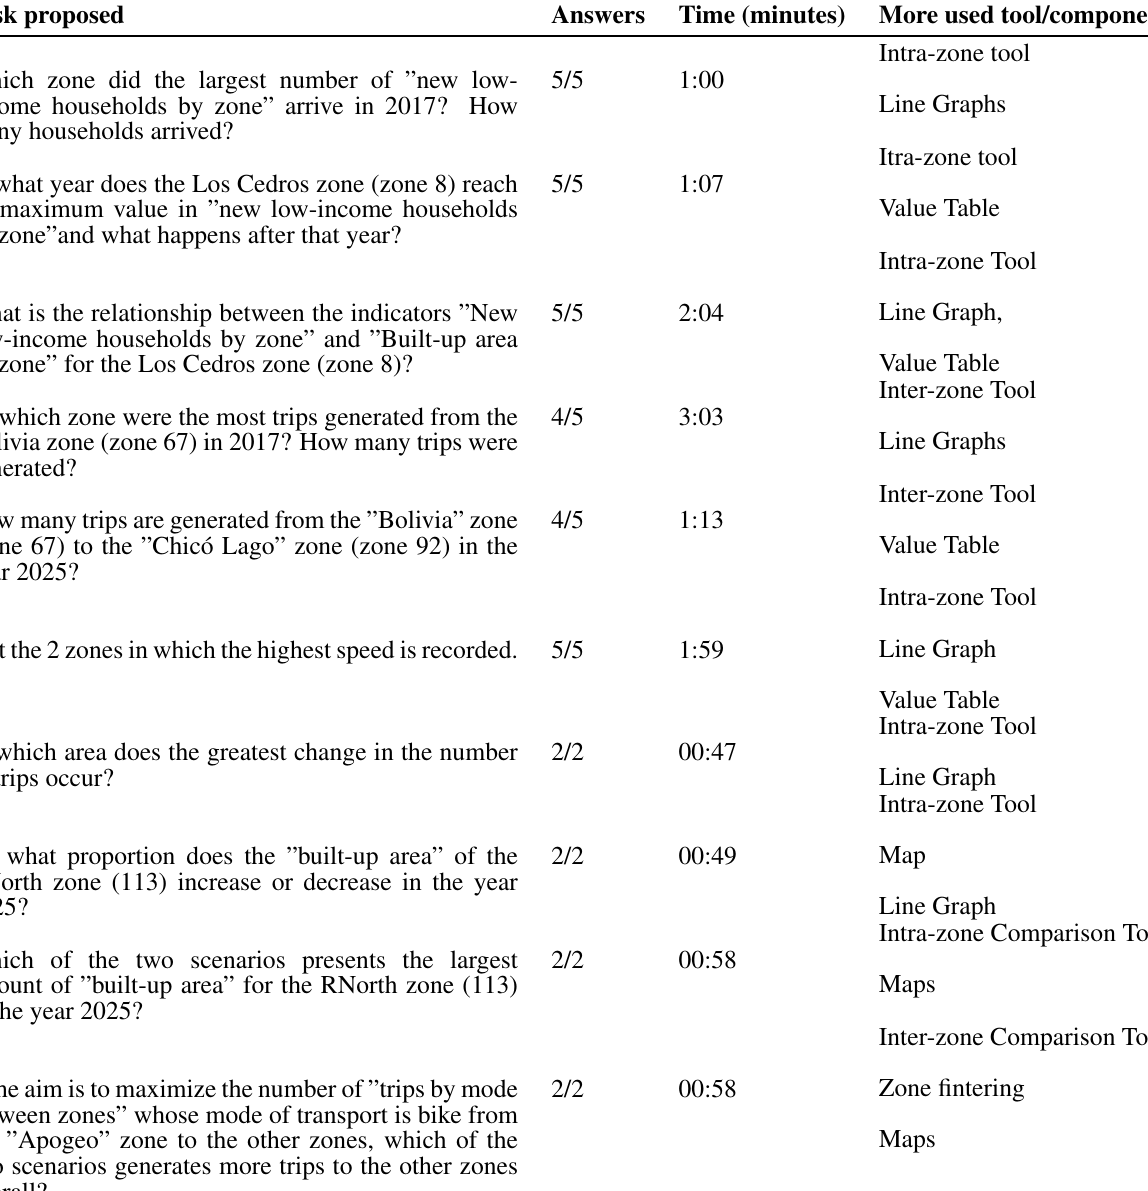
Table 1. Summary of expert session: Task and